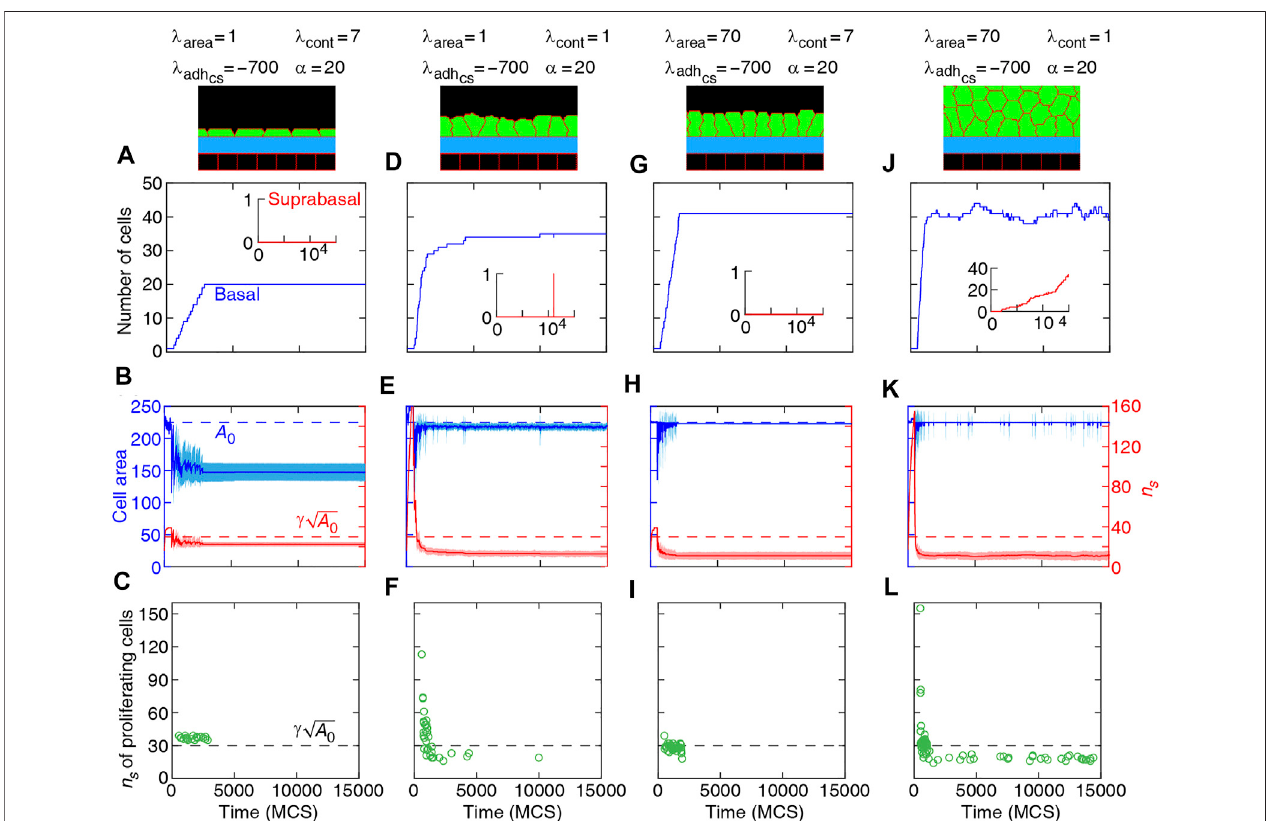
FIGURE8| Dynamics ofbasalcellsinfour differentcollective morphologies illustrated withsnapshotsand associatedmechanical parameters. Toprow (A,D,G,J) : number of basal cells (with adherence to the substrate) and suprabasal cells (without adherence to the substrate) versus time. Middle row (B,E,H,K) : area (left axis) and number of cell-substrate adhesion sites n s (right axis) for basal cells versus time. Solid curves: mean. Shaded region: SD. Bottom row (C,F,I,L) : n s of proliferating cells versus time. Orientation of cell proliferation is vertical, n div = (1, 0). α (cid:1) λ adh / λ adh . See Supplementary Movie S1 – S4 . cs cc